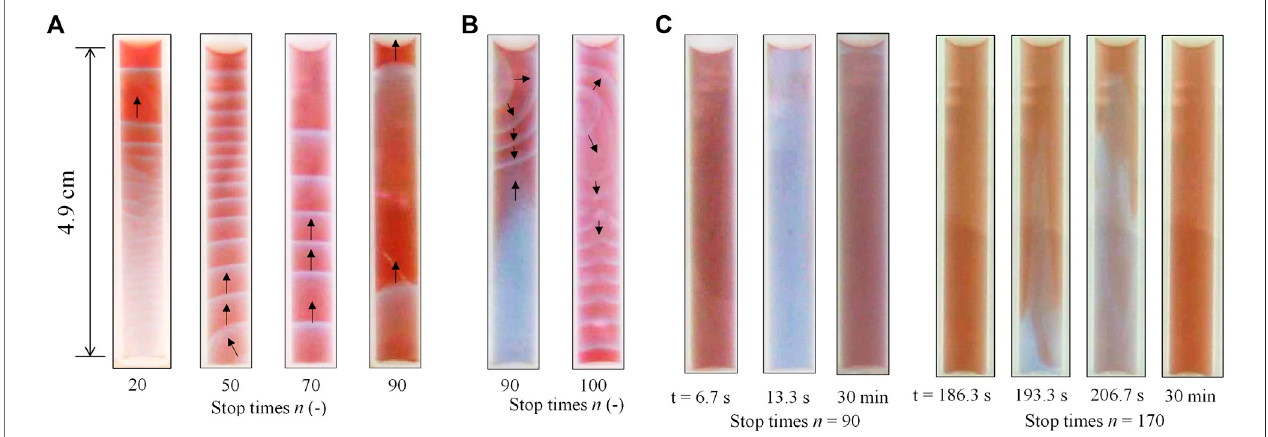
FIGURE 2 | Three different modes of the chemical wave were observed in the tube 30 min after the rotation-and-stop process; (A) upward wave, (B) complicated pattern, and (C) global-oscillation-like pattern. The black arrows ( Figures 2A,B ) indicate the direction of the wave